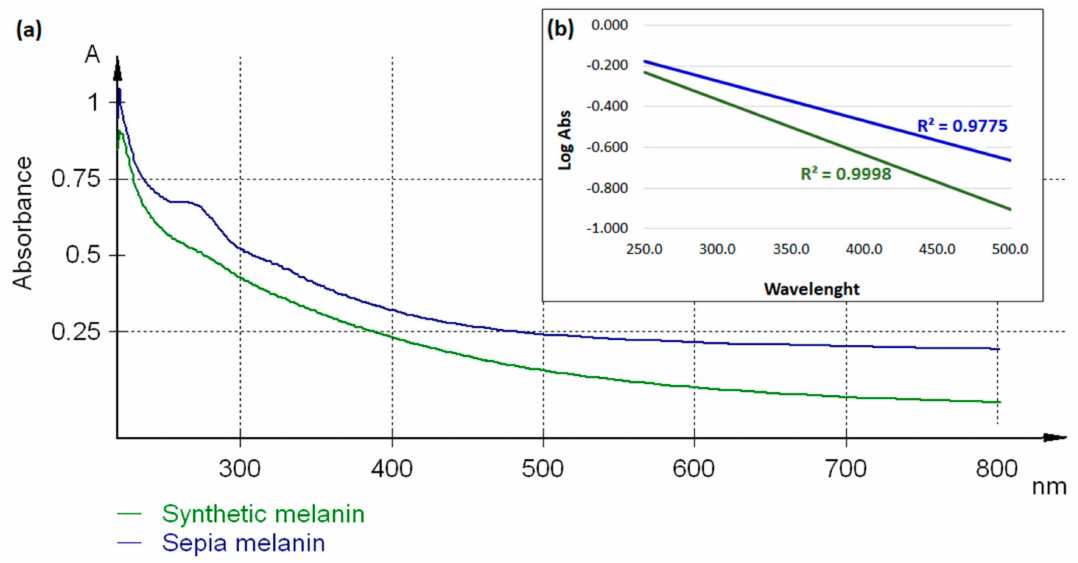
Figure 6. ( a ) The UV-VIS spectra of synthetic melanin (green) and melanin from Sepia o ffi cinalis (blue); ( b ) The linear curves obtained after plotting the logarithm of absorbance against the